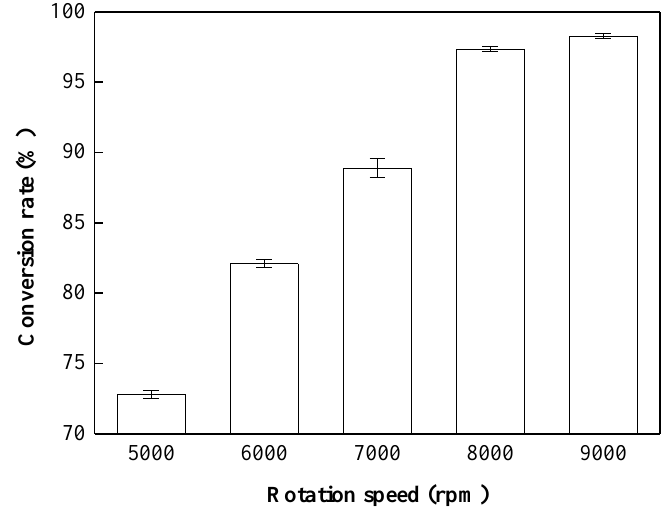
Figure 4. Effects of rotation speed on the transesterification reaction. Reaction conditions: methanol-to-oil molar ratio, 9:1, amount of catalyst used, 0.75 wt %; rotation speed, 5000–9000 rpm; reaction temperature, 65 °C; and reaction time, 8 min.